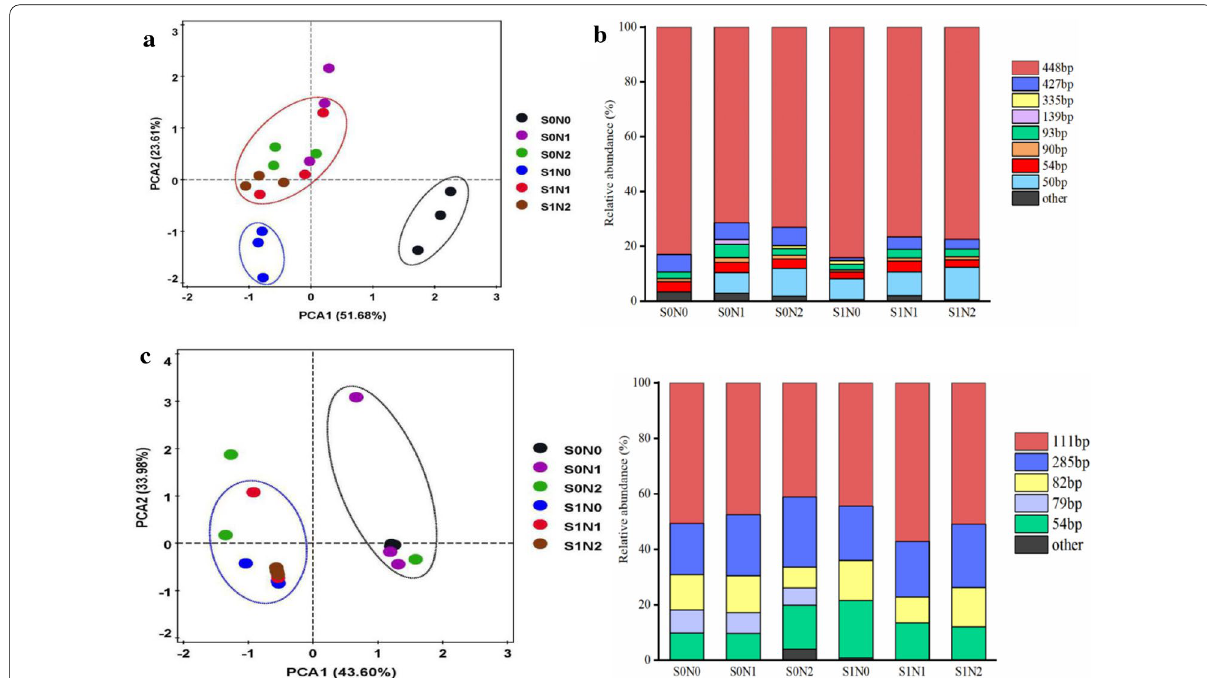
Fig. 5 Principal Component Analysis of ammonia oxidation archaeal ( a ) and bacterial ( c ) community and the relative abundance of T-RFs for ammonia oxidation archaeal ( b ) and bacterial ( d ) in different treatments. Data were mean S0N1: No straw mulching with 120 kg N ha − 1 , S0N2: No straw mulching with 180 kg N ha − 1 , S1N0: Straw mulching with no nitrogen, S1N1: Straw mulching with 120 kg N ha − 1 , S1N2: Straw mulching with 180 kg N ha −